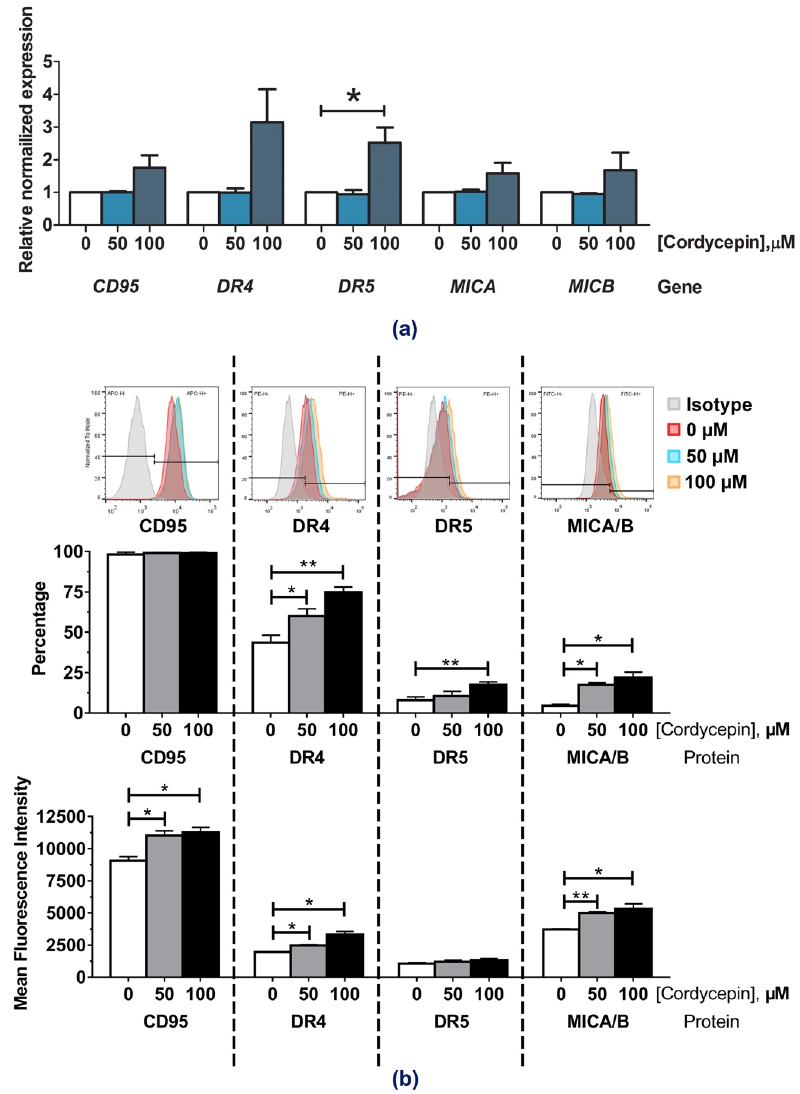
Figure 3. The effects of cordycepin on modulating CD95, DR4, DR5, MICA/B expression. Cordycepin at concentrations of 0, 50 and 100 μ M was put in with KKU-213A cells for 24 hours to determine its effect on CD95, DR4, DR5, MICA/B expression-alteration in either mRNA ( a ) or protein levels ( b ) by using real-time PCR and flow cytometry respectively. (* indicates p < 0.05, and, ** indicates p <